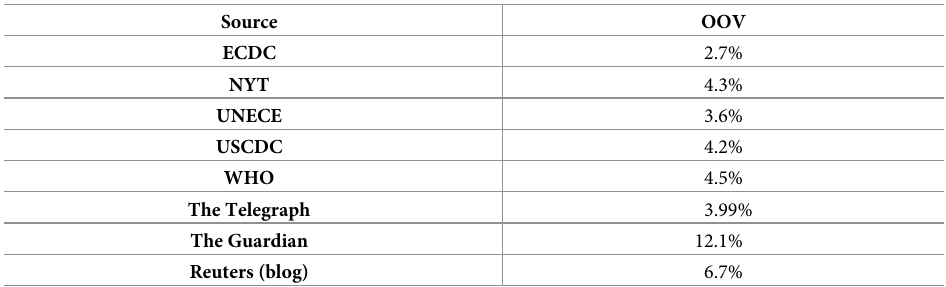
The choice of dictionary (Table 2) when constructing the text time-series and the sentiment index will determine both the richness of representation of the embedding and the expressive power of the sentiment index. A poor dictionary without variability will lead to modelling runs (sequences) of zeros when constructing the time-series from an input text. In addition, Table 3. Percentage of out-of-vocabulary